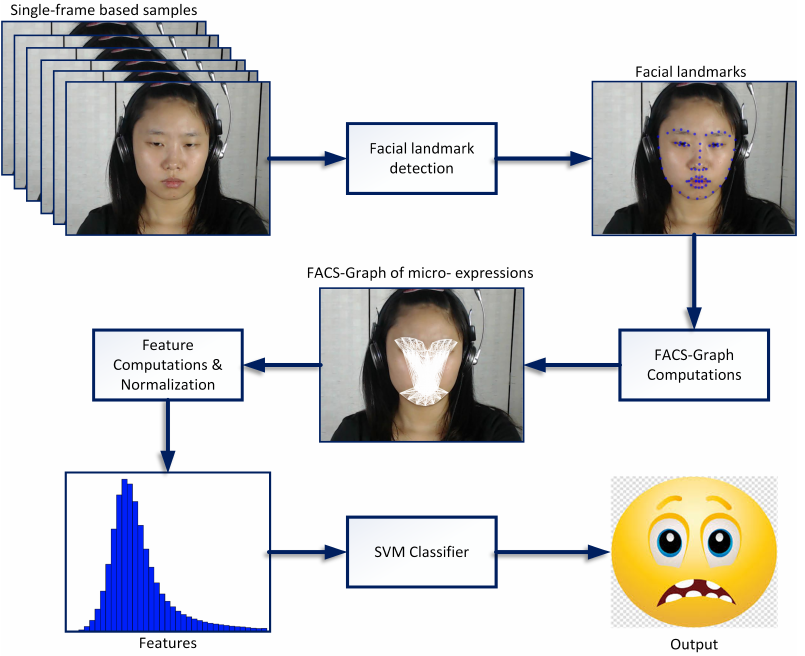
Figure 1. Principle of the proposed Facial Action Coding System (FACS)-based graph features for Micro-expression (ME)